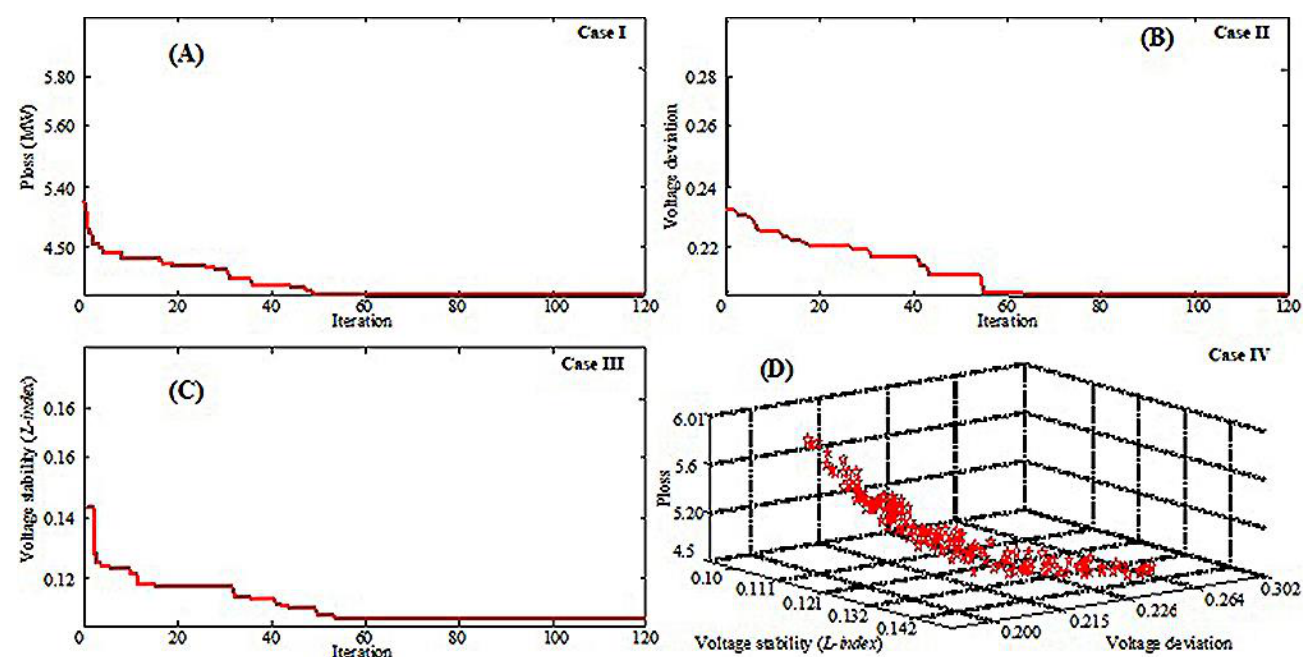
Figure 6. Pareto-optimal front of proposed technique, ( A ) case 1, ( B ) case 2, ( C ) case 3, and ( D ) case 4. Table 2. Comparison of transmission losses for different algorithms based on the optimization of the IEEE 30-bus system. Reproduced from [109], International Research Publication House: 2010. Compared Item